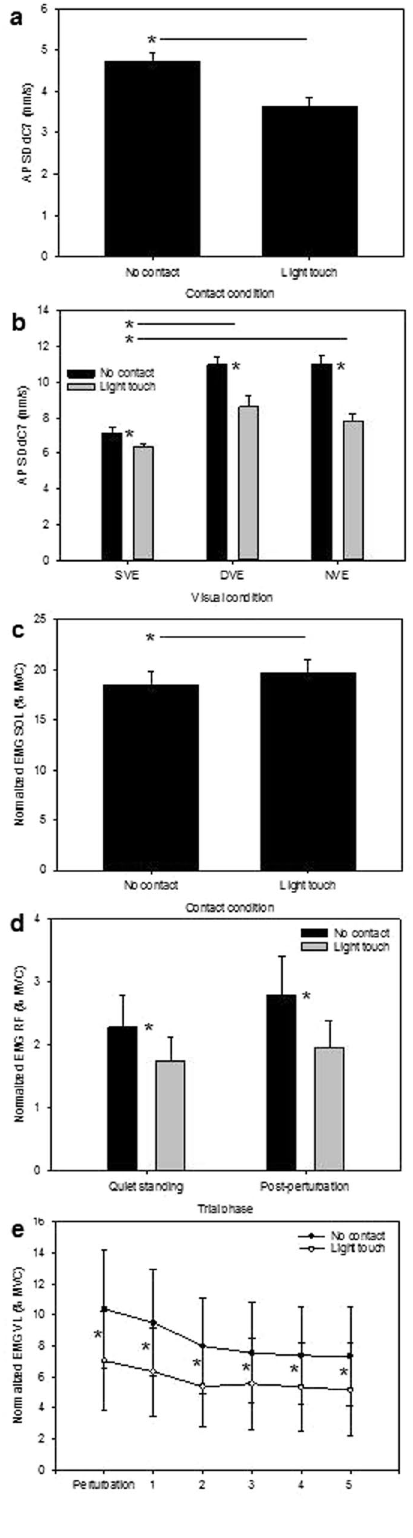
Figure 5. The effect of light touch on: ( a ) body sway in quiet standing, ( b ) body sway after the perturbation according to visual condition, ( c ) soleus activity in quiet standing, ( d ) rectus femoris activity in quiet standing and after the perturbation and e) vastus lateralis activity after the perturbation, according to time. MVC: maximum voluntary contractions. SVE: static visual environment; DVE: dynamic visual environment; NVE: No visual environment. See methods for description of time bins. * P < 0.05. Horizontal black lines with asterisks indicate significant post-hoc comparisons between major conditions depicted on the horizontal axis, while single asterisks indicate significant post-hoc comparisons between subconditions within a specific major